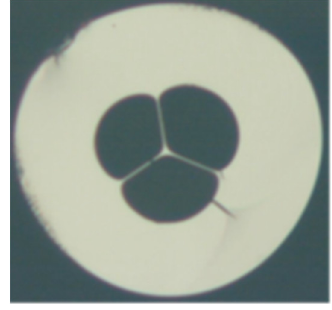
Figure 38. Microscope image of the three holes PCF with suspended Ge-doped silica core. It is combined with fiber Bragg grating and holes are filled with analyte then used as refractive index sensor (Reproduced from [107], with the permission of OSA publishing).